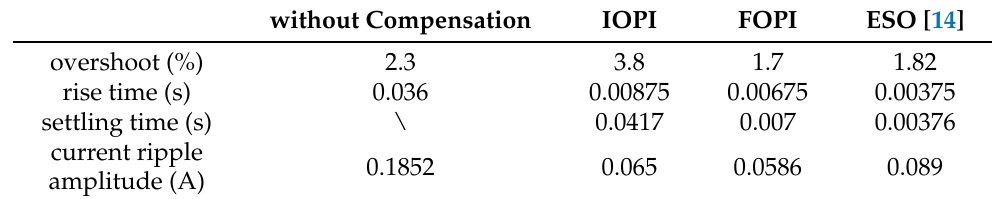
Table 9. The performance index comparison of I q step current response in the experimental.